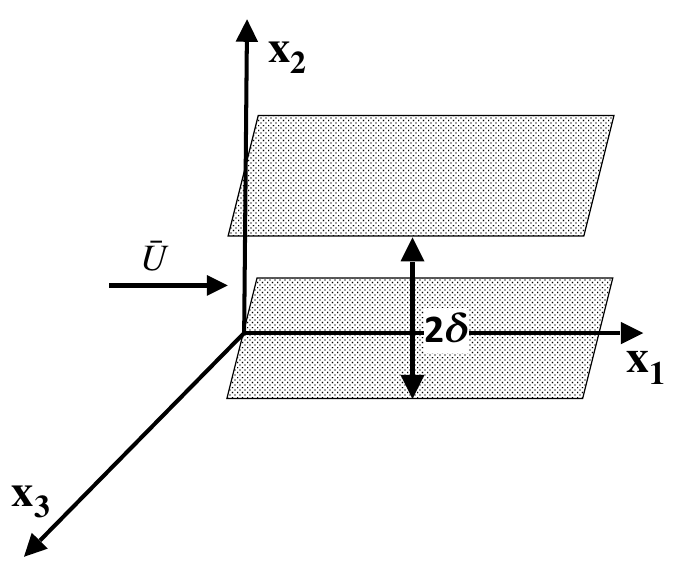
Figure 2. Flow configuration and coordinate